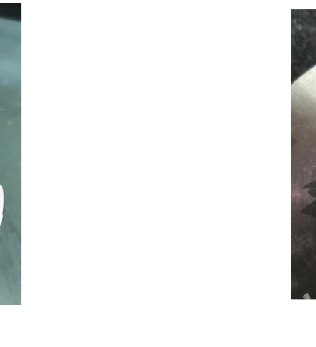
Figure 3. Fractures of the four tested groups on the titanium abutment: ( a ) Group A: porcelain fused to metal; ( b ) Group B: monolithic zirconia; ( c ) Group C: zirconia coping with a ceramic veneer; ( d ) Group D: full contour all-ceramic lithium disilicate.